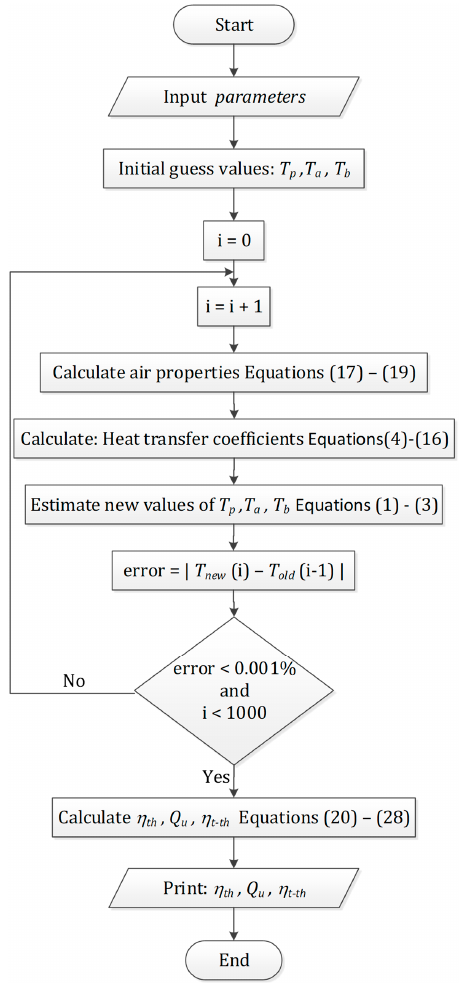
Figure A1. Flowchart of the summarised logic algorithms of the in-house code.